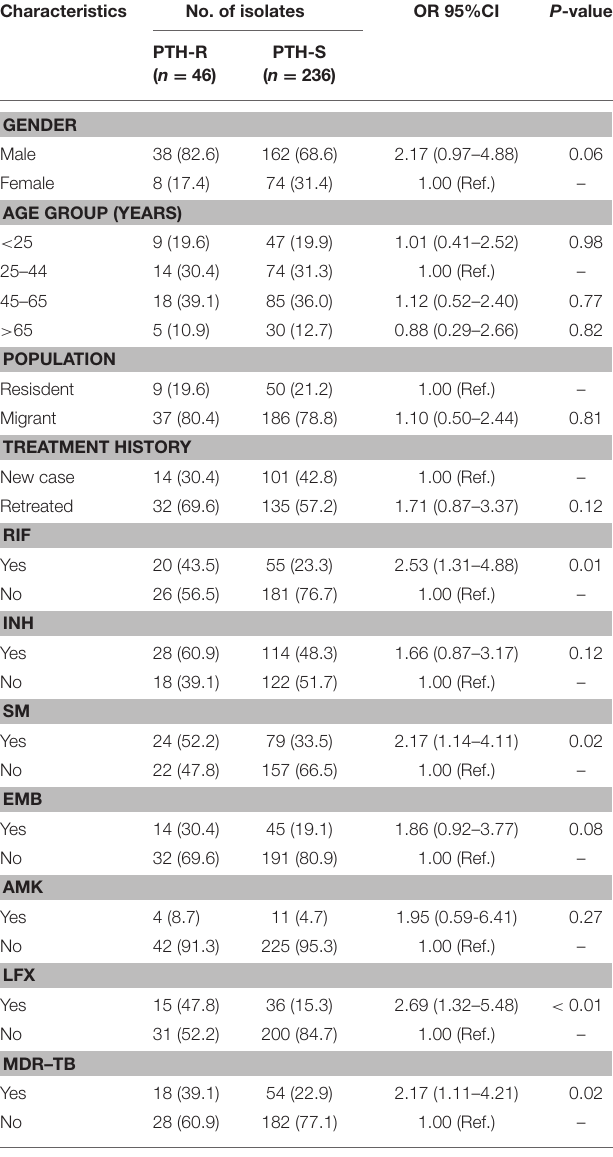
TABLE 2 | Univariate analysis of factors associated with PTH resistance.